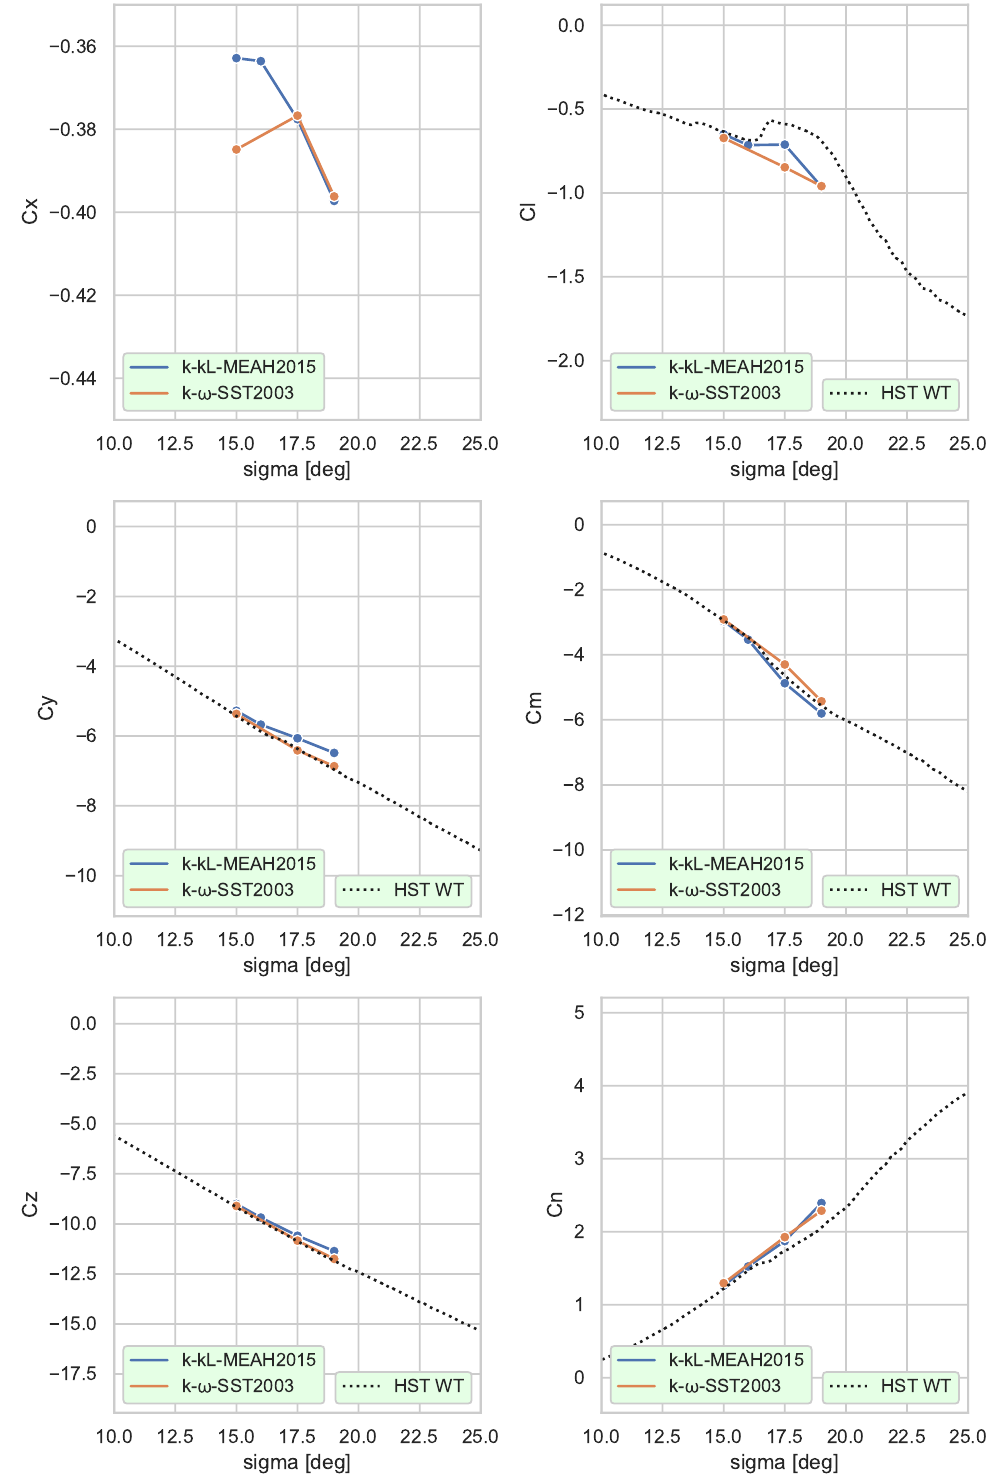
= 5 × 10 5 , λ = 45°; Ref